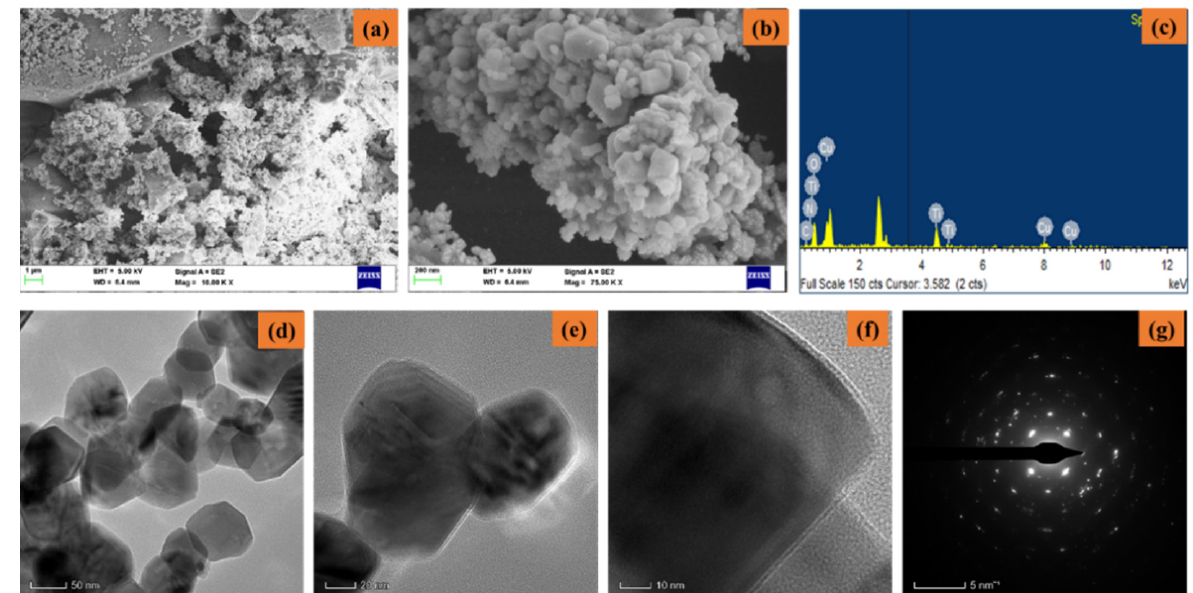
Figure 3. Electron microscopic pattern of nanocomposites: Lower and higher magnifications of FESEM ( a , b ), EDAX spectra ( c ), TEM images ( d – f ), and SAED pattern ( g ) of nanocomposites.